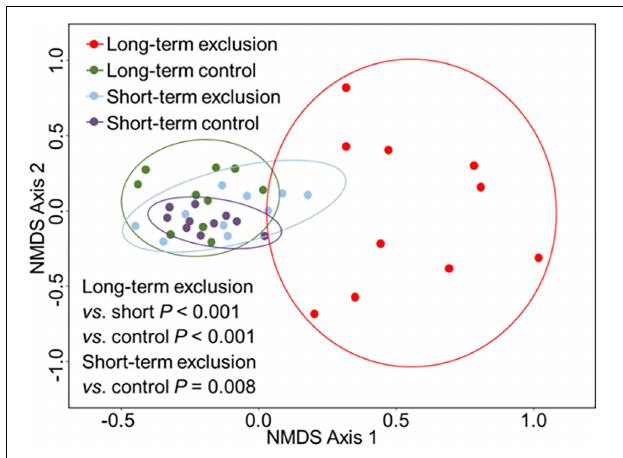
FIGURE 3 | Non-metric multidimensional scaling (NMDS) ordination of vegetation in plots based on the height data of different species. Ordinations were based on Bray–Curtis